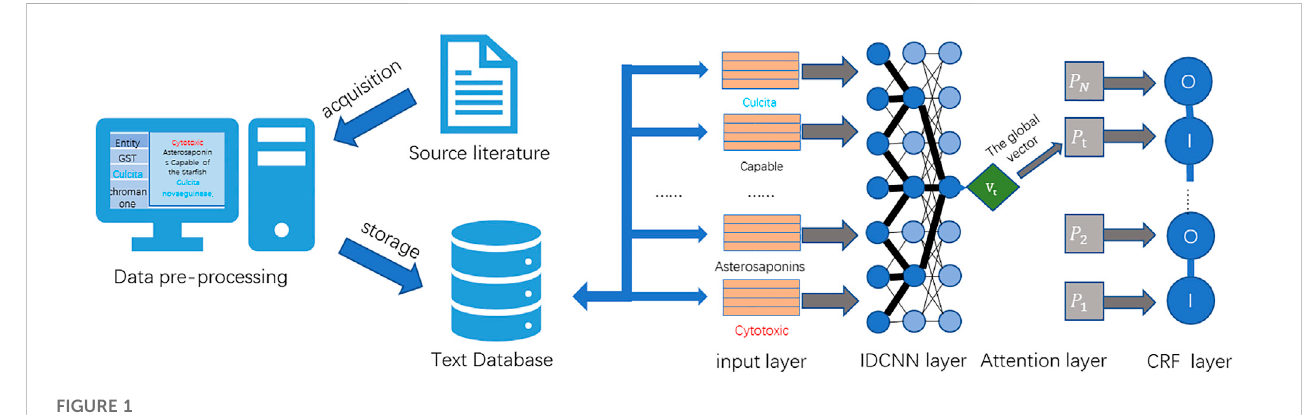
FIGURE 1 Overall technology